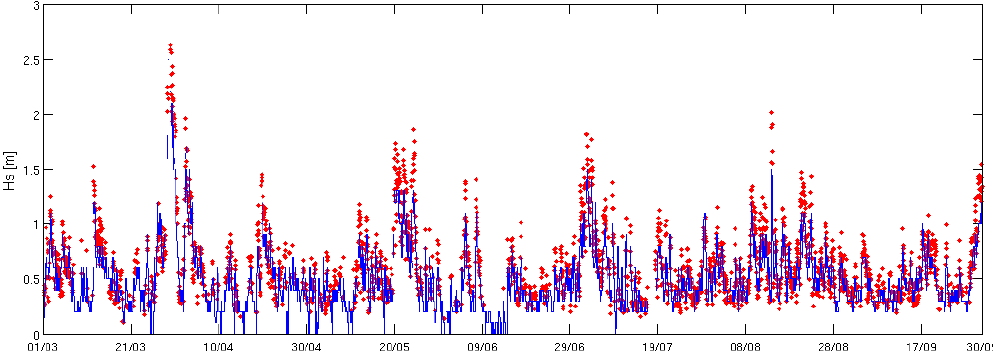
Figure 12. Time series comparison between the measured data at CB (blue) and the averaged HF radar data at range cells from 3–7 selected by applying 50% outliers. Time series data are for 2014.